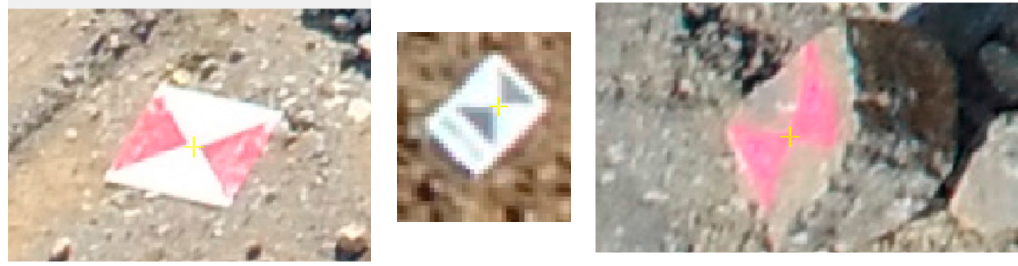
Figure 4. Three types of the GCPs, images taken from the UAV.